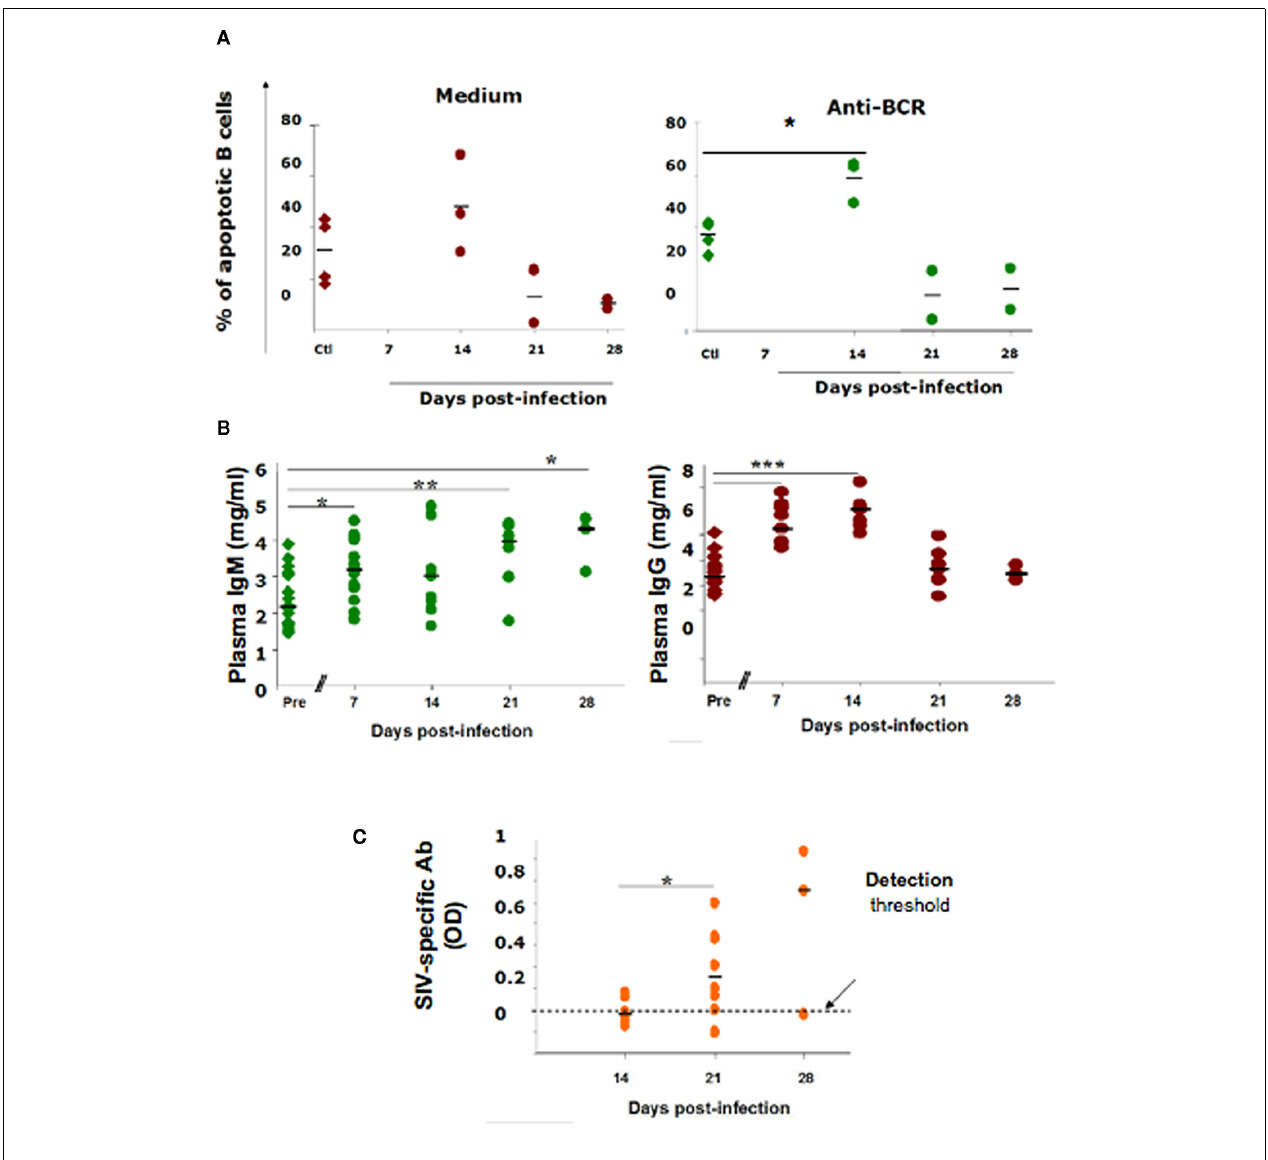
hypodiploid B-cells from one animal. Bars represent the mean percentages. * p Value < 0.05. (B) Plasma IgM and IgG concentrations were quantified before infection (Ctl, diamonds ) and 7, 14, 21, and 28dpi ( filled circles ). Horizontal bars indicate the median concentrations. Statistically significant differences are indicated (* p < 0.05; ** p < 0.01; *** p < 0.001). (C) IgG, IgM, and IgA SIV-specific Ab concentrations in the plasma of SIV-infected macaques 14, 21, and 28dpi. Horizontal bars indicate the median OD values. * p Value <